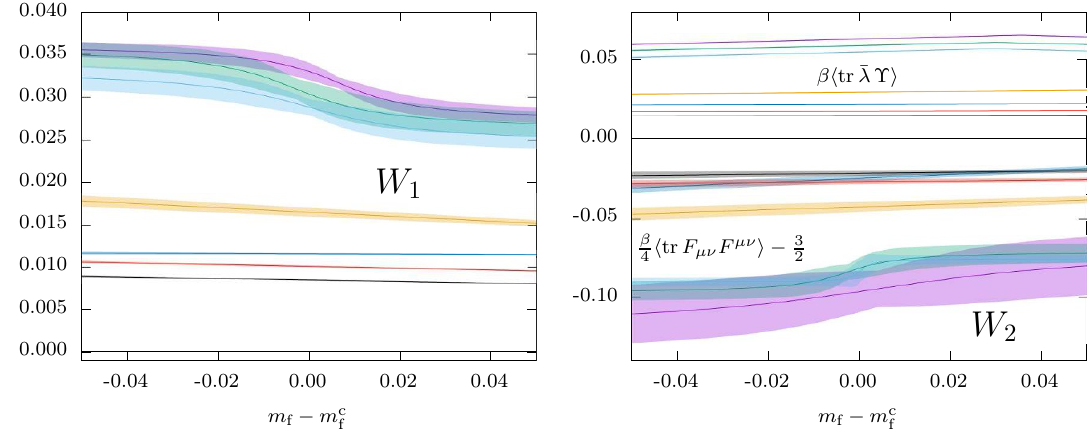
Figure 6. Ward identities (4.4) as functions of m f (cid:0) m c for various values of (cid:12) between 14 and f 100. The colors represent di(cid:11)erent (cid:12) : 14 (cid:15) , 15.5 (cid:15) , 17 (cid:15) , 40 (cid:15) , 60 (cid:15) , 80 (cid:15) and 100 (cid:15) . For W 1 (left panel) we show the (cid:12)ts and standard deviations (con(cid:12)dent band). For W 2 (right panel) we show